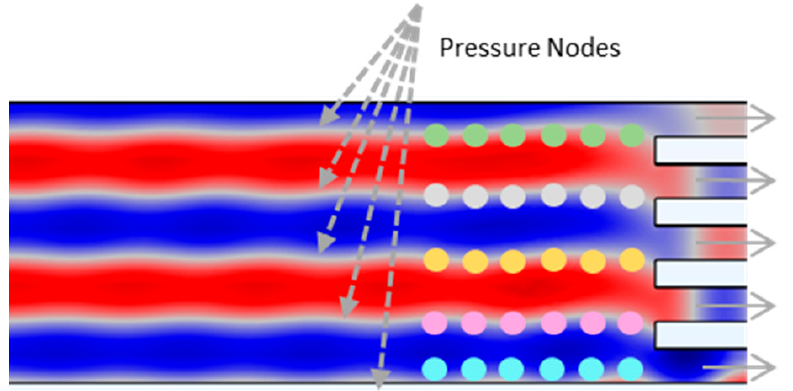
Figure 2. Acoustic pressure distribution in the straight outlet section. Due to the applied SAWs, five nodal pressure lines corresponding to the lateral position of the outlets were generated.